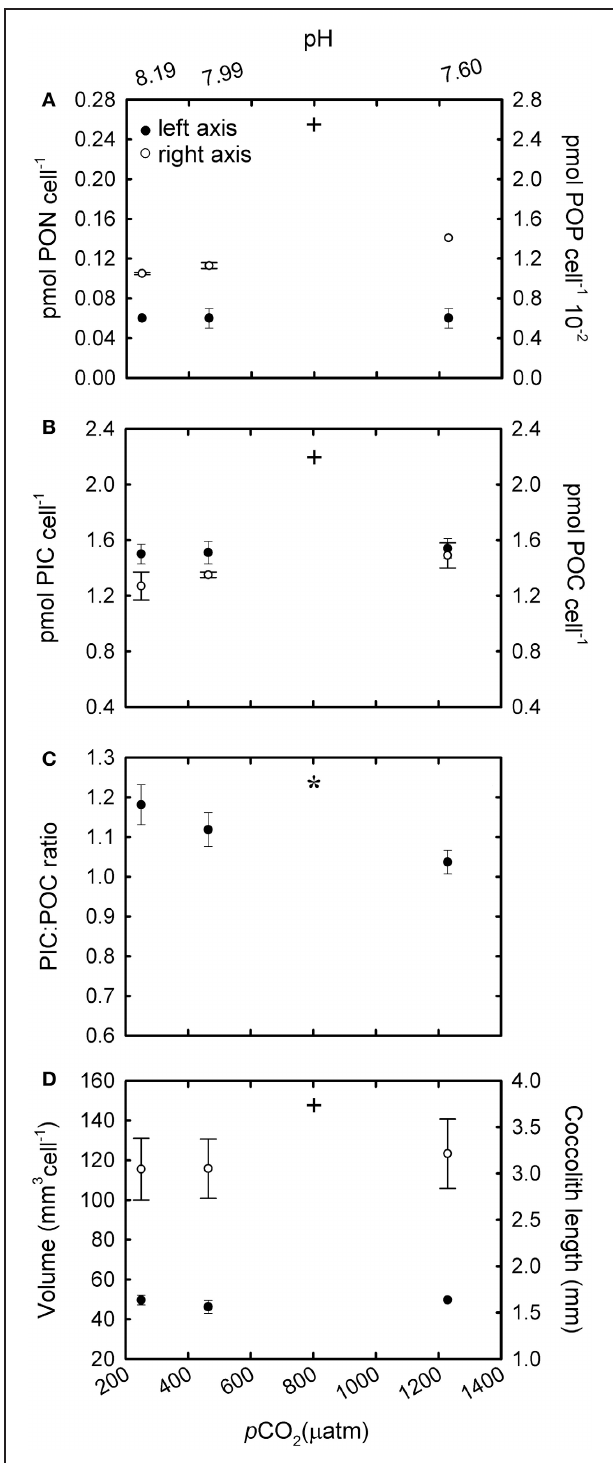
FIGURE 5 | The response of Emiliania huxleyi NZEH to different CO 2 scenarios under nitrate limited conditions. (A) Cellular PON quota, cellular POP quota; (B) Cellular PIC quota, cellular POC quota; (C) PIC:POC; (D) Coccosphere volume ( µ m 3 ) and coccolith length ( µ m). ( ∗ and + ) significant differences ( p < 0 . 05) between CO 2 levels within nutrient treatments from One-Way ANOVA analysis: left ( ∗ ) and right( + )